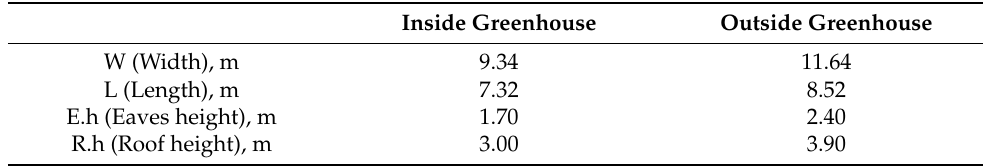
Figure 2. Schematic diagram of greenhouse. Table 1. Greenhouse